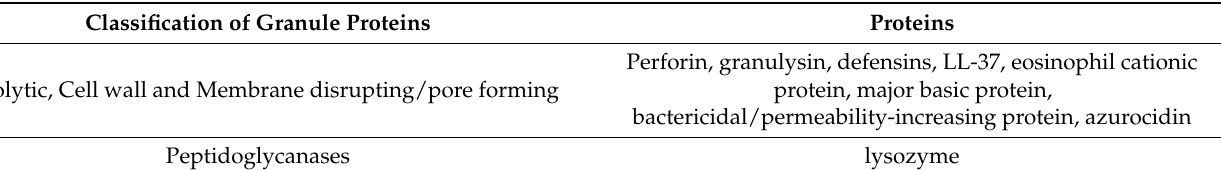
Table 4. Classification of proteins found in